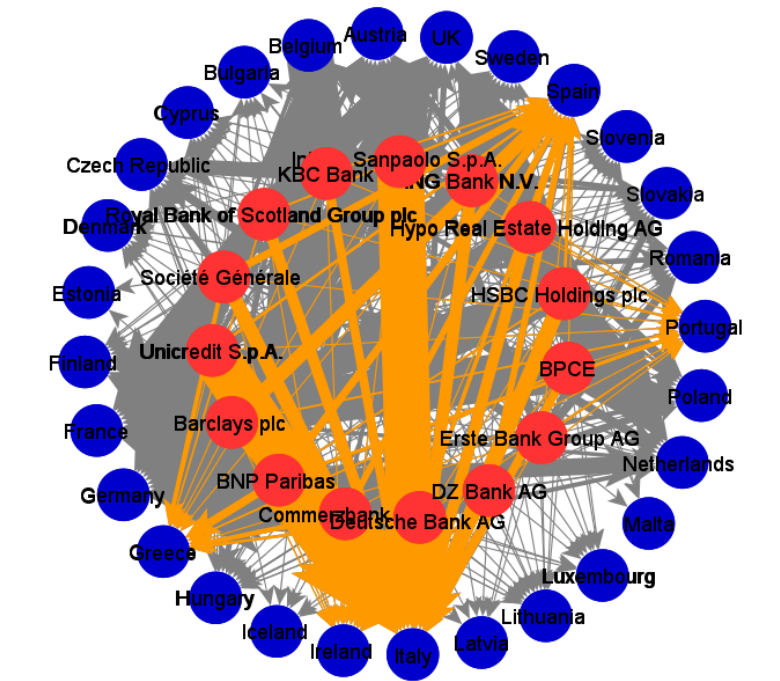
Figure 5. The highly connected core with weighted links in December 2010. The links amounted to €1065.3 billion, which was almost 60% of the sovereign debt in the assessed bank-sovereign network. Peripheral sovereign debt exposures (Greece, Ireland, Italy, Portugal, and Spain) are marked in orange. Visualization created with Visone